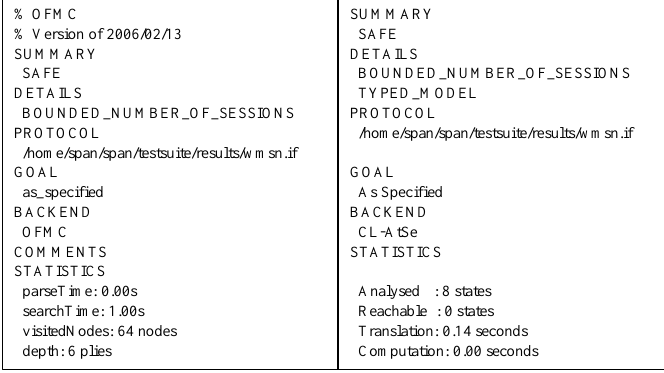
Figure 7. AVISPA simulation